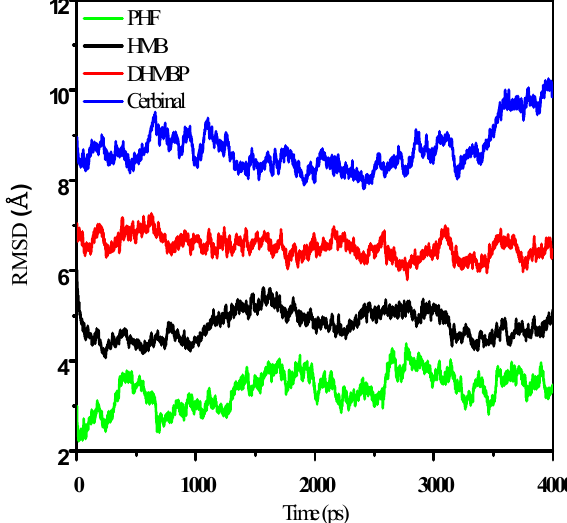
Figure 4. The root mean square displacement/deviation (RMSD) of PHF, HMB, DHMBP and cerbinal system. The curve was separated in parallel for easy viewing.